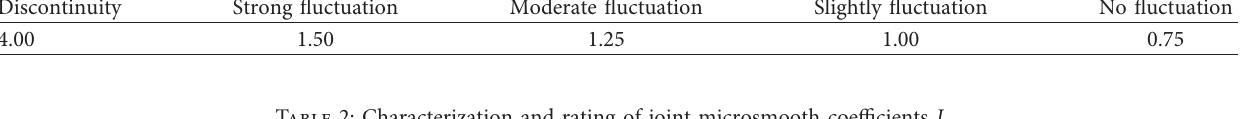
Table 1: Characterization and rating of joint macroscopic fluctuation coefficients J